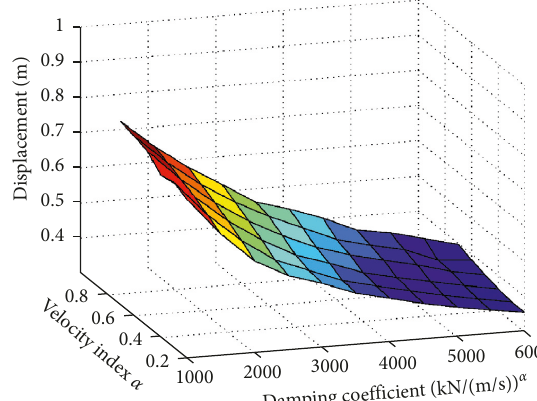
Figure 14: Longitudinal bending moment at the bottom section of the main tower.